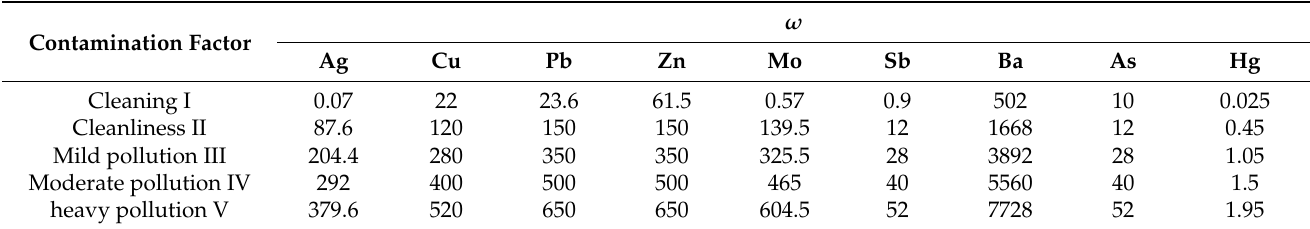
Table 1. Evaluation standard of potentially toxic elements contamination/mg · kg − 1